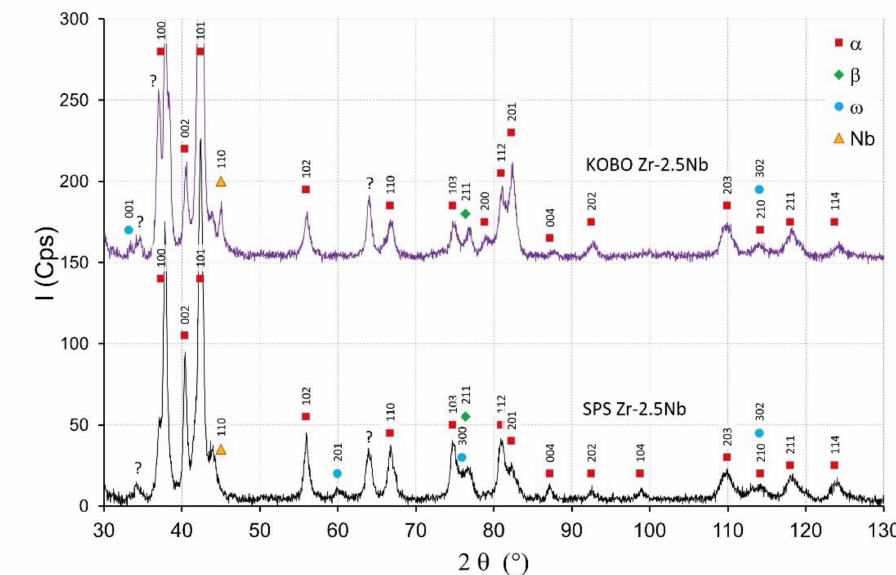
Figure 4. The X-ray diffractograms of the Zr-2.5mass%Nb materials obtained by SPS and KOBO-extrusion.